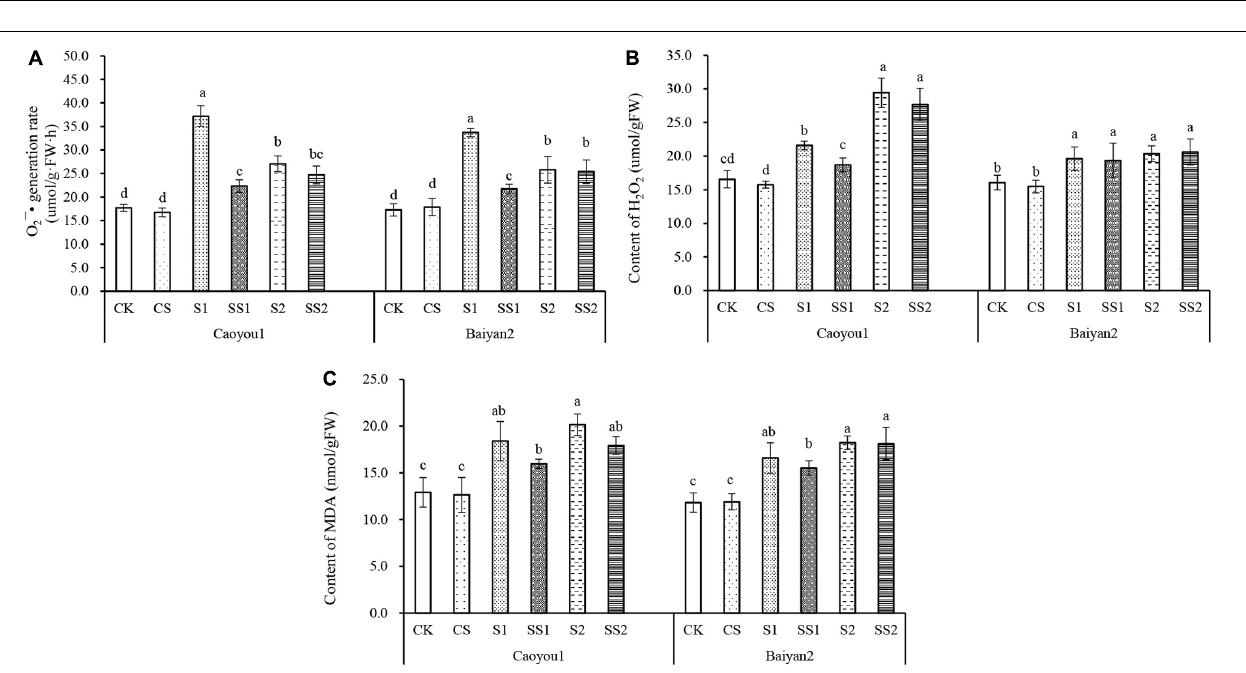
FIGURE 4 | Effects of Spd application on O 2 •− production rate (A) , H 2 O 2 (B) , and MDA content (C) under salt stress in the oat seedlings. CK, Nutrient solution + distilled water; CS, Nutrient solution + 0.75 mM Spd; S1, 70 mM salt + distilled water; SS1, 70 mM salt + 0.75 mmol/L Spd; S2, 100 mM salt + distilled water; SS2, 100 mM salt + 0.75 mmol/L Spd; Different lowercase letters indicate significant differences between treatments at 0.05 level.